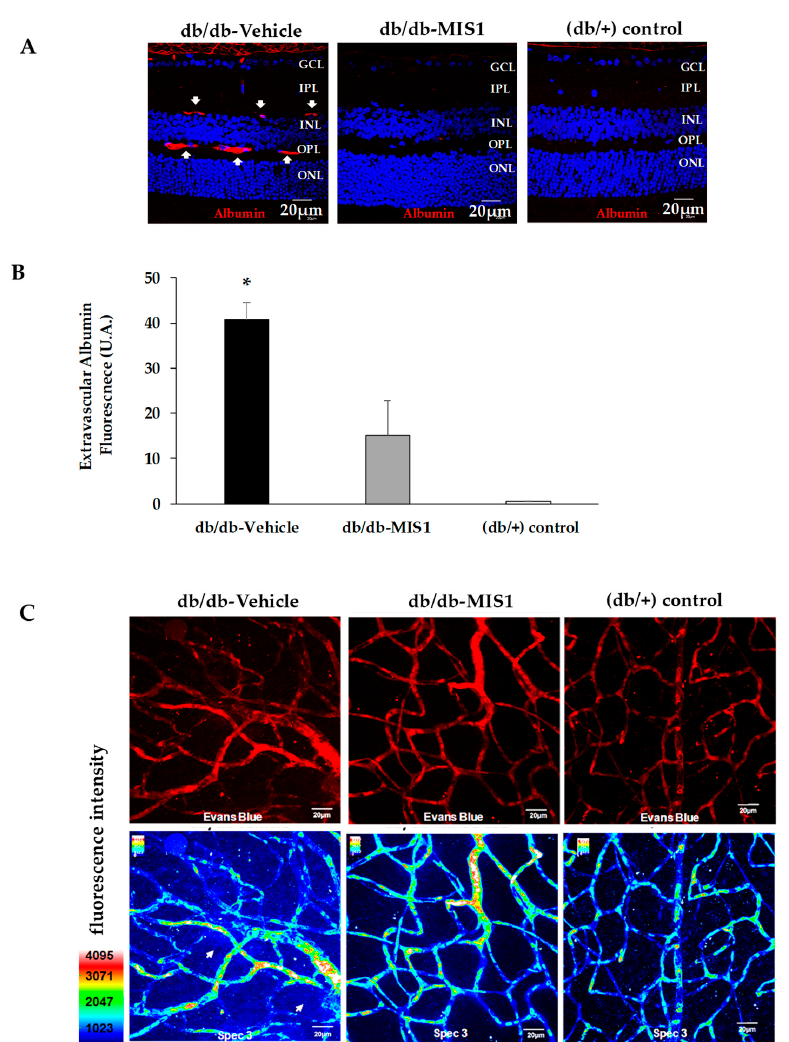
Figure 5. Effect of topical administration (eye drops) of SOCS1 peptidomimetic (MIS1) on vascular leakage. ( A ) Confocal microscopy images showing albumin immunofluorescence (red) in a representative diabetic mouse treated with vehicle, a diabetic mouse treated with MIS1 and a non-diabetic (db/+) mouse. Nuclei were labeled with Hoechst (blue). The presence of extravasated albumin is indicated by arrows. ONL: outer nuclear layer; OPL: outer plexiform layer; INL: inner nuclear layer; IPL: inner plexiform layer; GCL: ganglion cell layer. ( B ) Quantification of albumin immunofluorescence ( n = 7 mice per group). AU: arbitrary units. Data are expressed as mean ± SD. * p < 0.05 (db / db treated with vehicle vs. the other groups). ( C ) Upper panel: Confocal immunofluorescence images of vascular permeability assessed by Evans blue dye (red) leakage in retinal whole mounts. Lower panel: Confocal immunofluorescence images with Spec3 by FV1000, Olympus. Scale bars, 20 µ m. For quantification 3 mice from each group were